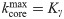
Plot of the phase diagram of the solutions of the nonlinear model.The stability diagram as a function of Kγ is computed using the exact solution (11) of the nonlinear dynamical system for the same 9 empirical mutualistic networks used in Fig 3. The tipping line is plotted according to the nonlinear model which predicts that the tipping point is given for kcoremax=Kγ. All the networks lie in the region kcoremax>Kγ and thus they are stable, as they should.